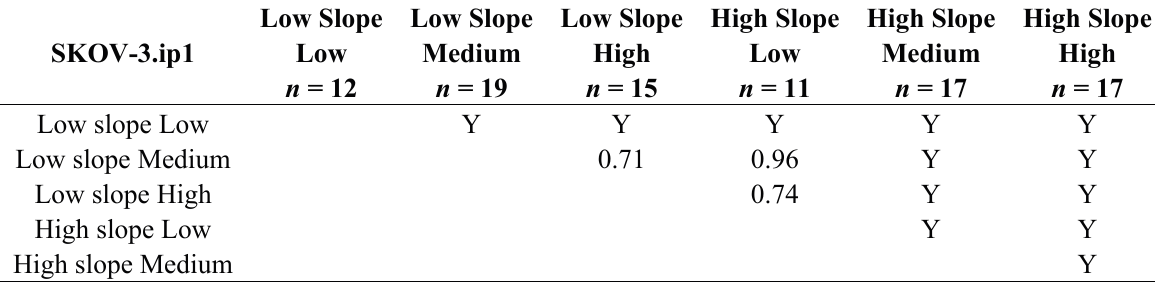
Table 2. p values from pair-wise t -tests of migration speeds of SKOV-3.ip1 cells at low, medium, and high concentration regions of the low and high slope LN gradients. n = number of cells used in the analysis. “Y” corresponds to p <